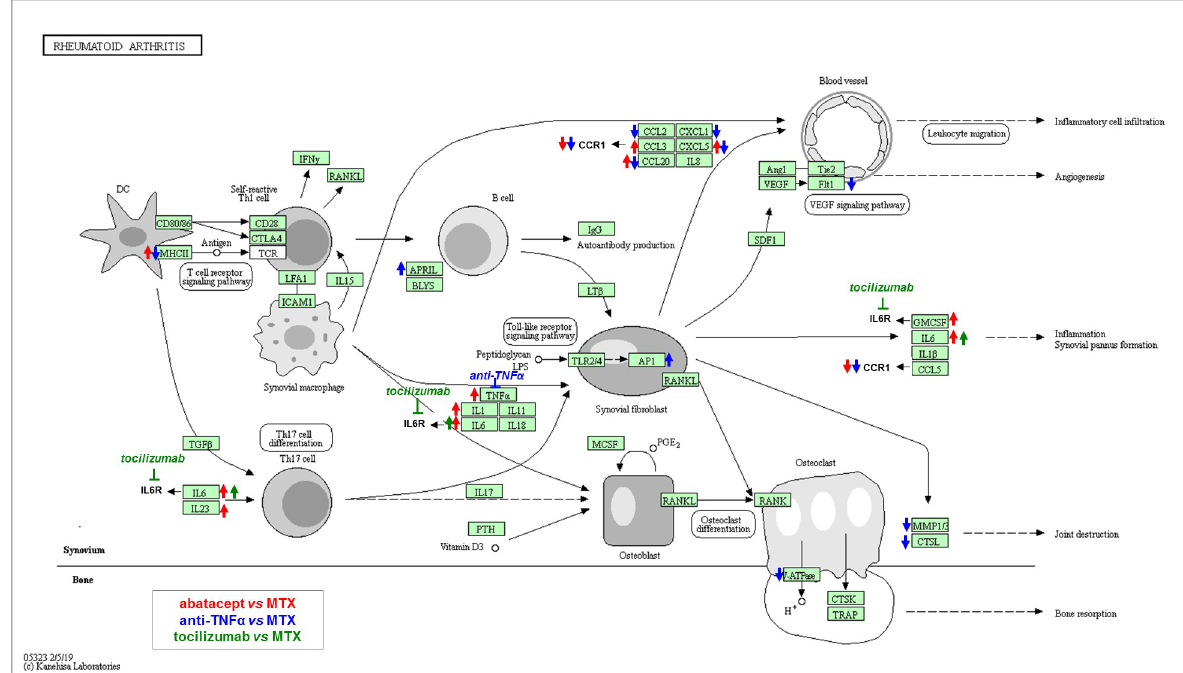
Fig 5. Schematic representation of the transcriptional changes occurred in patients treated with abatacept, tocilizumab and anti-TNF α compared to the methotrexate (MTX). KEGG pathway map hsa05323 Reumathoid arthritis -Homo sapiens (human) modified and published under permission of the copyright holder Kanehisa